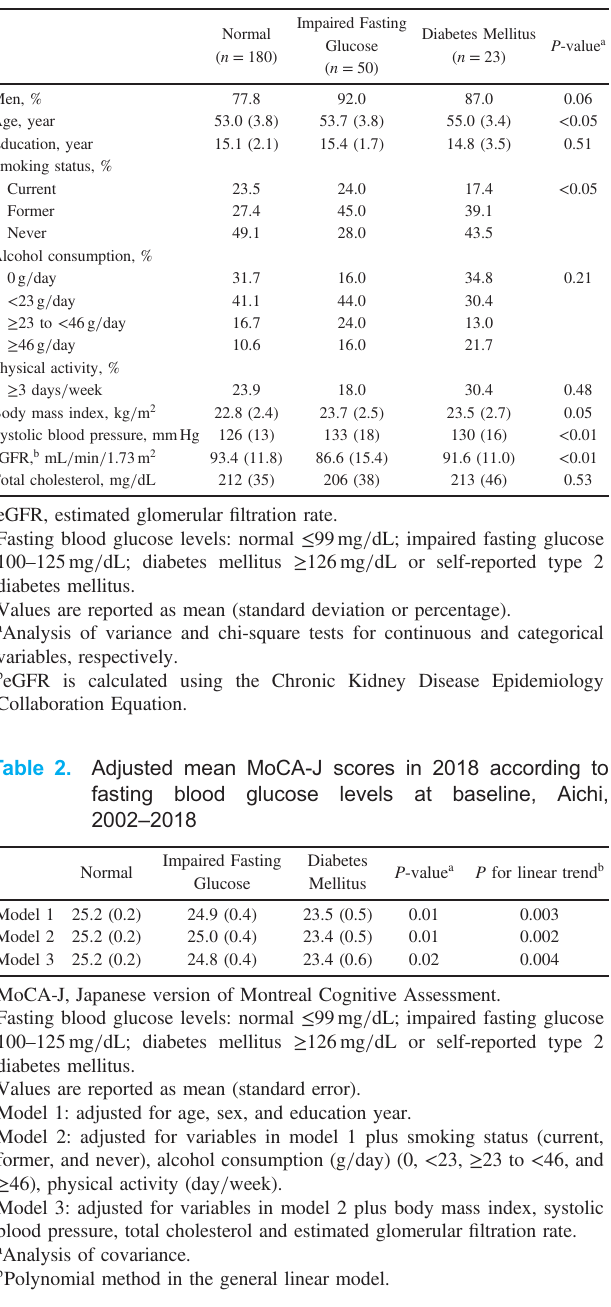
Table 1. Baseline characteristics of the participants according to fasting blood glucose levels at baseline, Aichi, 2002